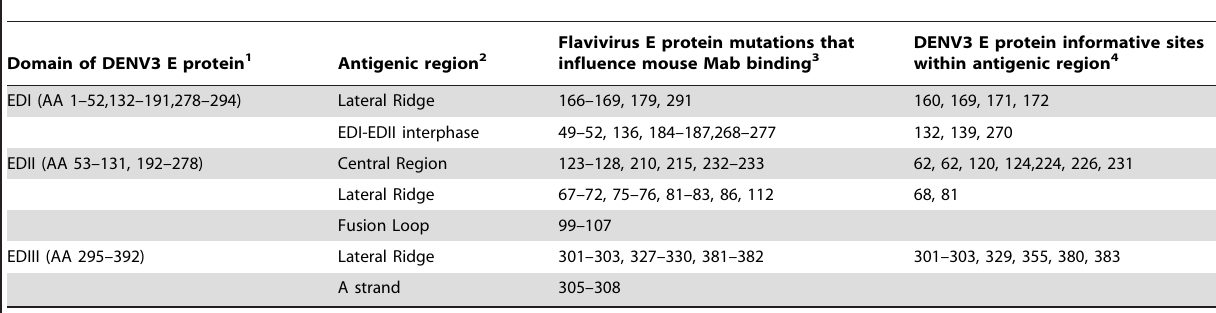
Table 1. Location of antigenic sites and informative sites on dengue type 3 E protein.